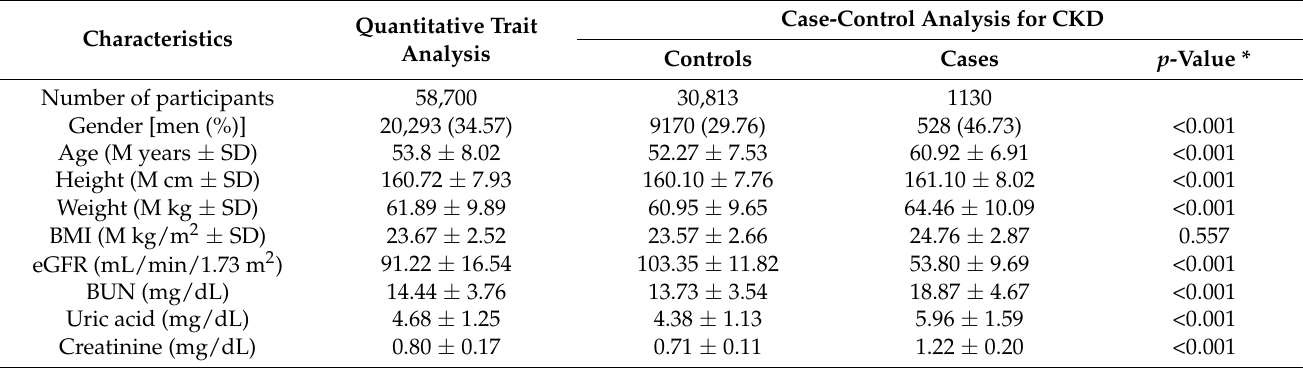
Table 1. Characteristics of participants in the Korean